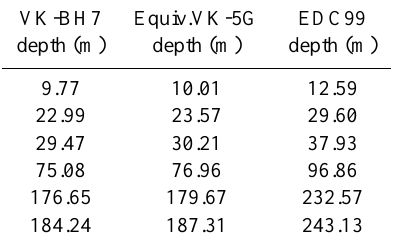
Table 3. List of volcanic tie points between the Vostok BH7 and EDC99 ice cores. The equivalent Vostok 5G depths are given for convenience, following the BH7-5G synchronisation discussed in the